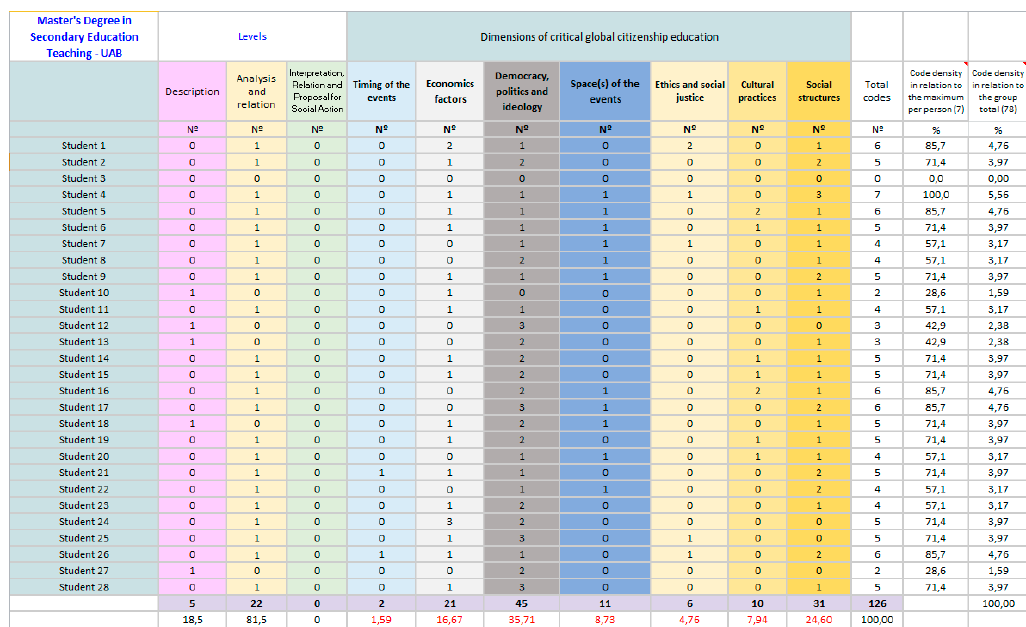
Figure 4. Data emptying matrix—University of Málaga (UMA).